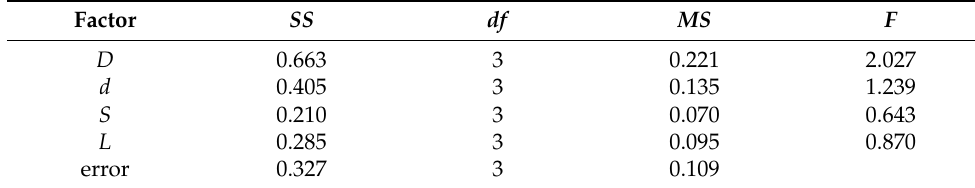
Table 3. Analysis of variance for experimental